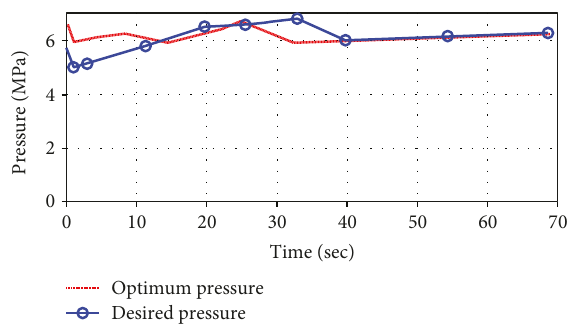
Figure 10: Comparing desired pressure & optimum pressure